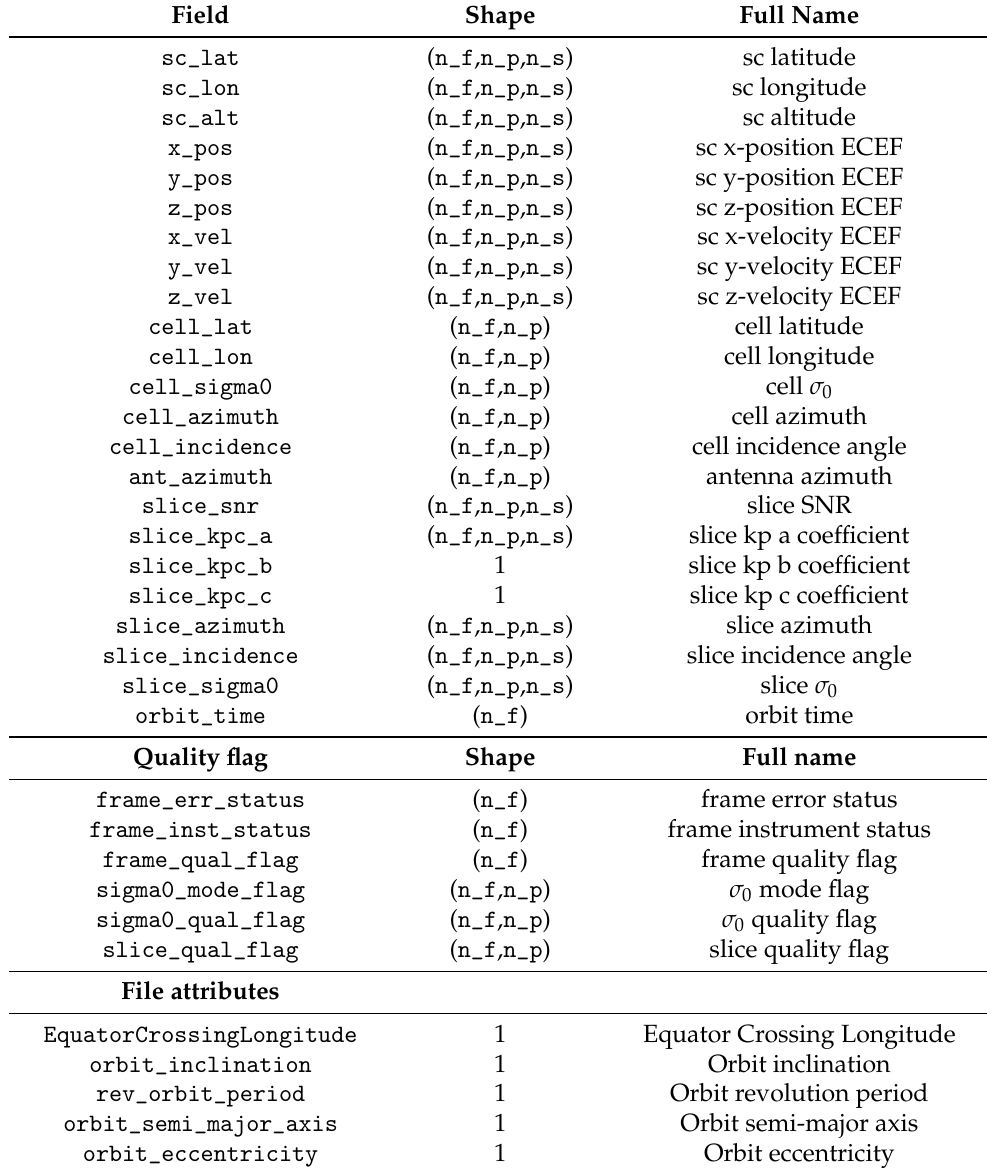
Table 1. List of fields used in this study. Under “shape”, n_f , n_p and n_s stand for “number of frames”, “number of pulses” and “number of slices”, respectively. n_p is equal to 100 and n_s to 8, while n_f may vary with the orbit. Its typical value is around 11,240. The acronyms “sc” and “ECEF” stand for “spacecraft” and “Earth-Centered Earth-Fixed”,